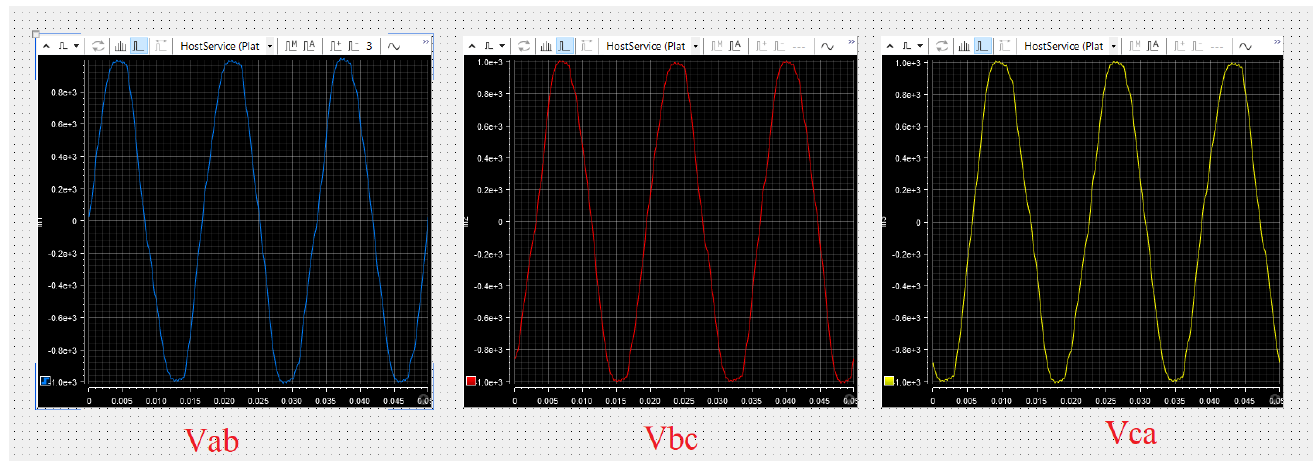
Figure 27. dSPACE measured line-to-line